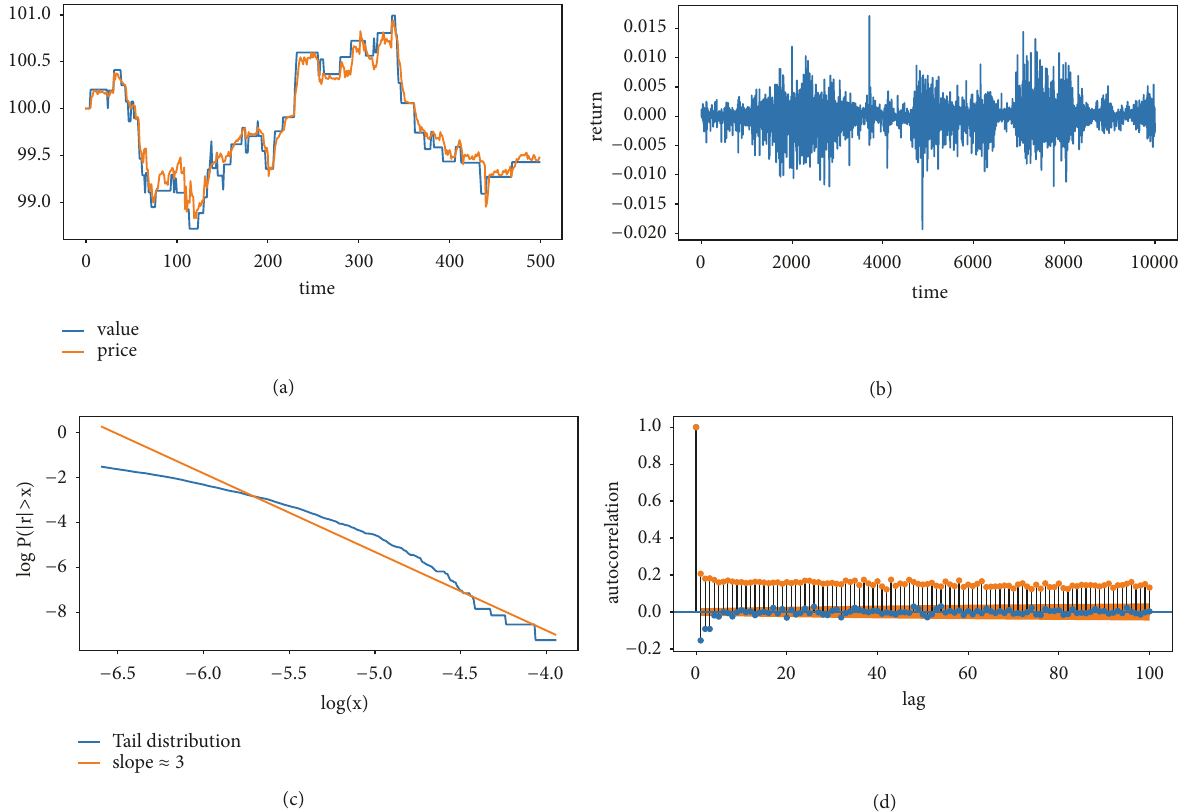
Figure 4: Simulation results . (a) Simulated trajectory of asset prices and values (for clarity, only the 500 first sets of data are shown); (b) return series (in percentage); (c) tail distribution of the absolute return in the log-log scale and a least-square fit for values; (d) autocorrelation function of return and absolute return; the autocorrelation function of absolute return decays slowly, indicating that the volatility has long- memory characteristics.